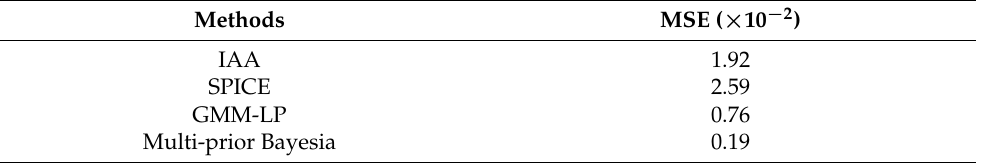
Table 5. MSE results at range cell 2435